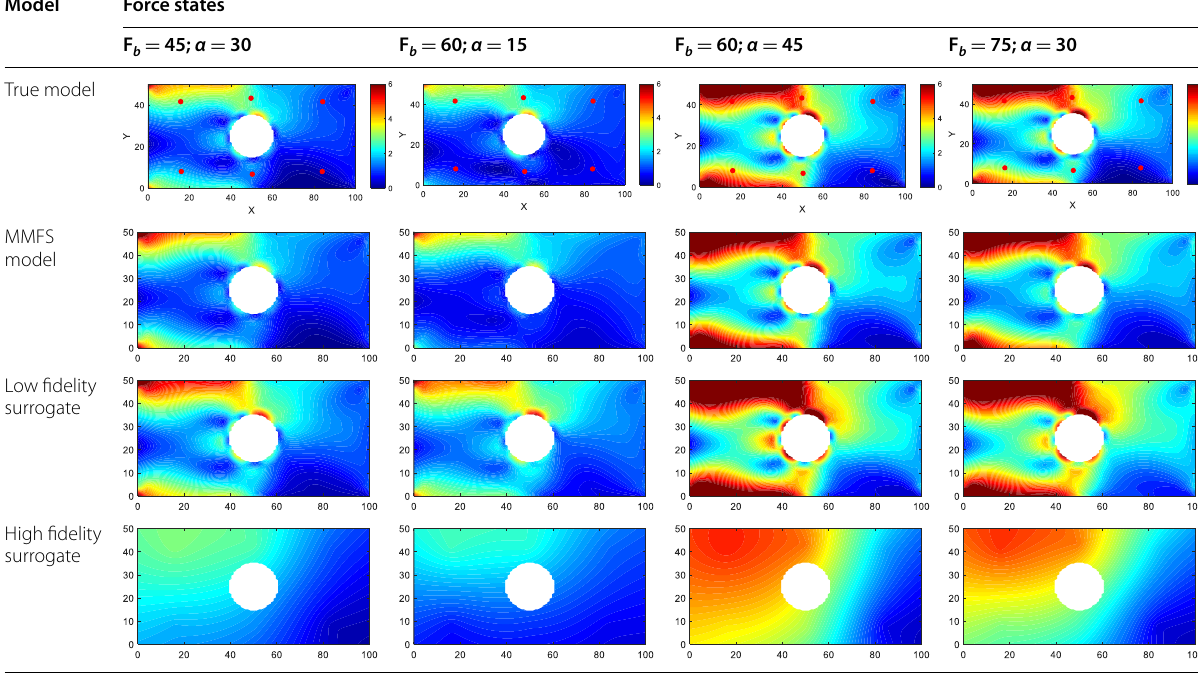
Table 3 Comparison of models in different force states